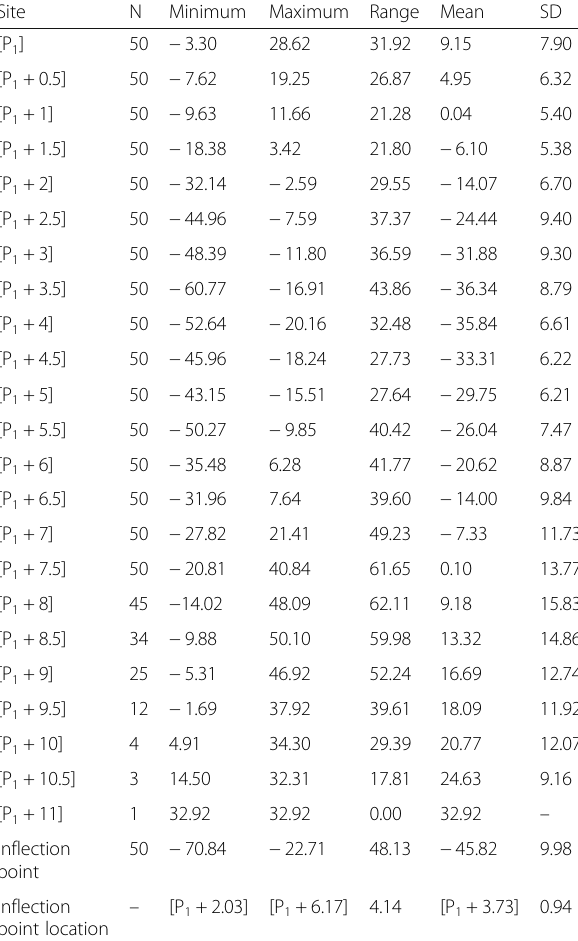
Table 1 The torque angle values at the 0.5-mm increments and at the inflection point of the incisor in Figs. 1 and 2 are shown in this table. As the palatal CEJ of this incisor is located at the x coordinate point 7.70, the most cervical 0.5-mm increment is [P 1 + 7.50]. Incremental subtractions were calculated for the